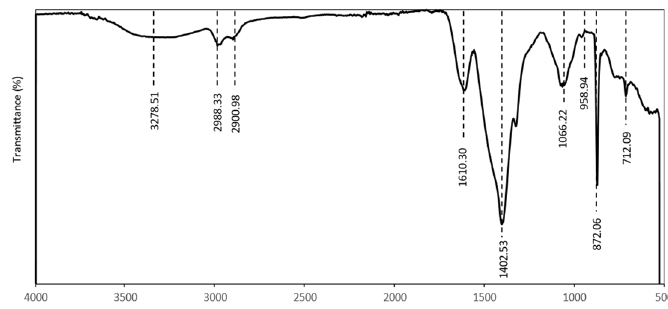
Figure 9. FTIR of dextran-coated nCPs (2g DEX).